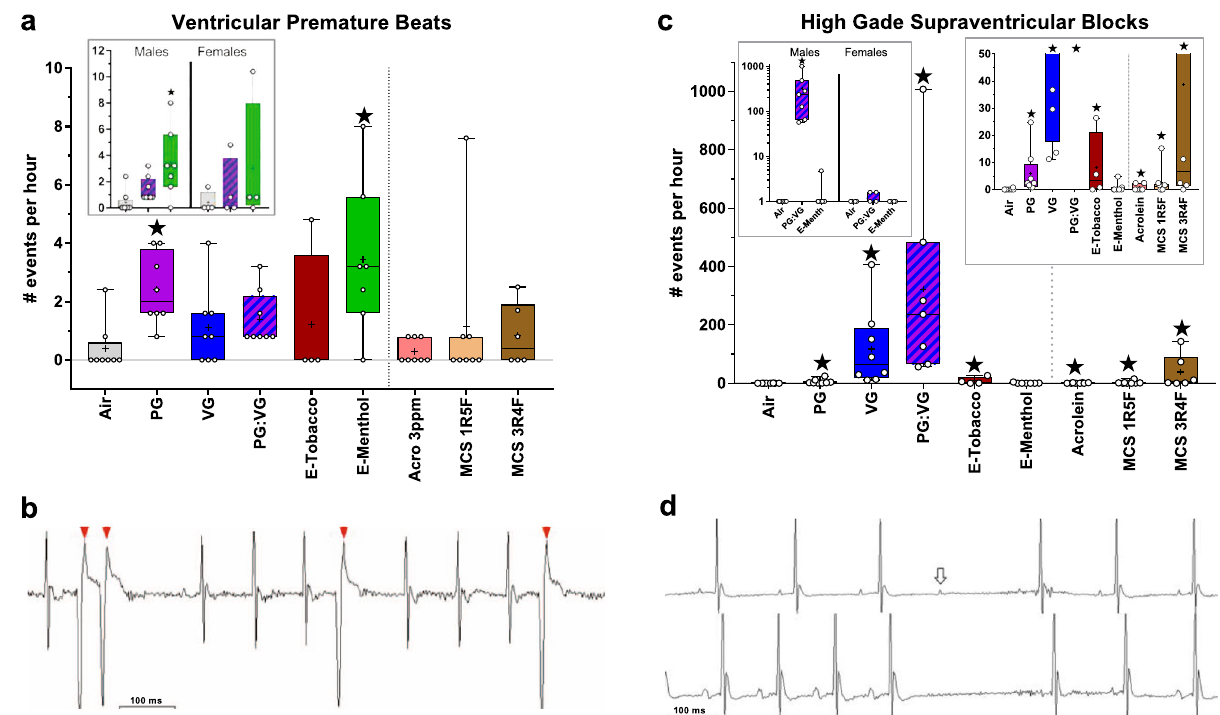
Fig. 6 | Inhalation exposure to E-cig aerosols increases cardiac arrhythmias. a Mean±SEM number of arrhythmias per hour of ECG monitoring in males and both sexes (inset). b Representative VPBs (arrows) in an E-Menthol-exposed male. c Mean±SEM number of high-grade SVB events per hour of ECG monitoring in males (smaller valuesin right inset) and females (left inset). d Representative high- gradeSVBs, resembling atrioventricular blockwith non-conductedP waves(upper waveform,arrow),sinoatrialblocklacking P waves(lowerwaveform);similarblock events with noise preventing con fi rmation of P or its absence are not shown.